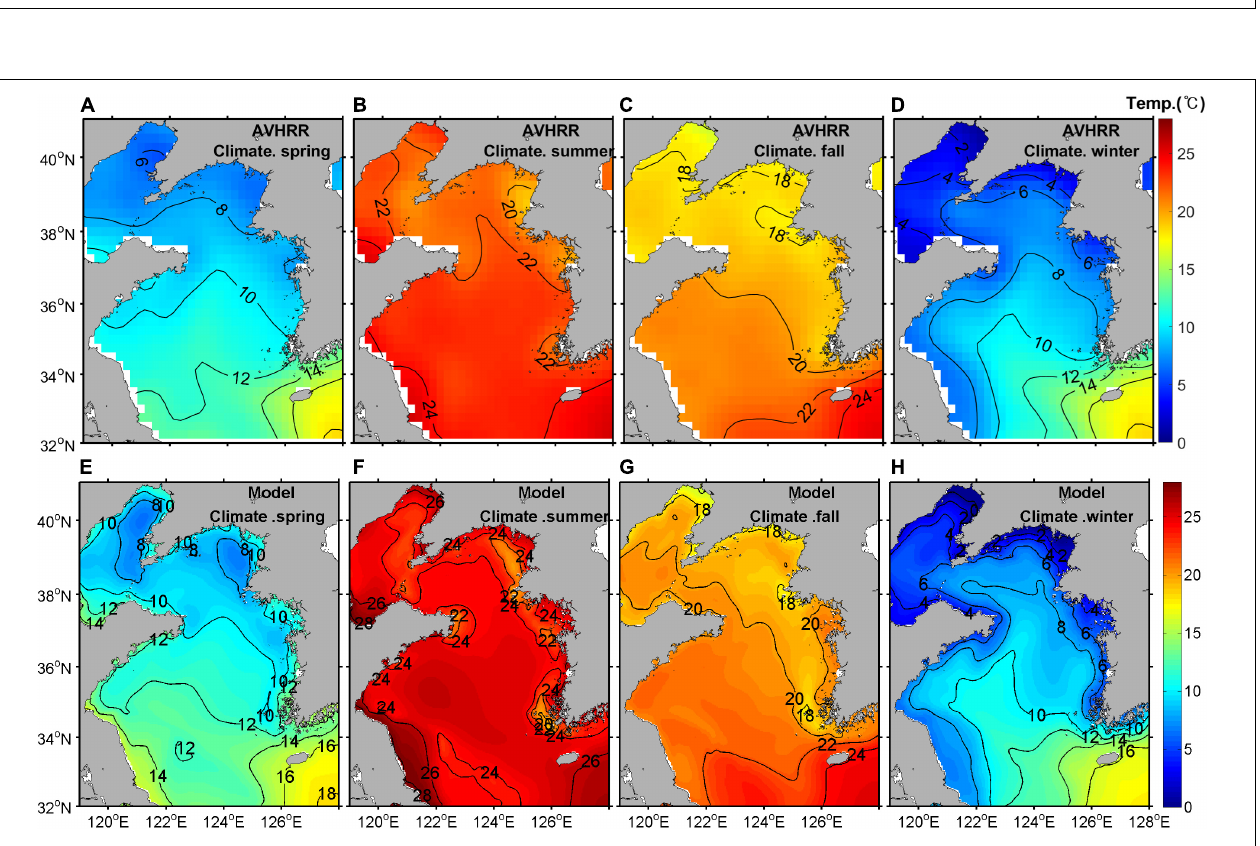
FIGURE 7 | Horizontal distribution of surface temperature from the AVHRR satellite data (A–D) and model outputs (E–H) in spring (A,E) , summer (B,F) , fall (C,G) , and winter (D,H) averaged for the period 2006–2019 (units are ◦ C). AVHRR, Advanced Very High Resolution Radiometer.